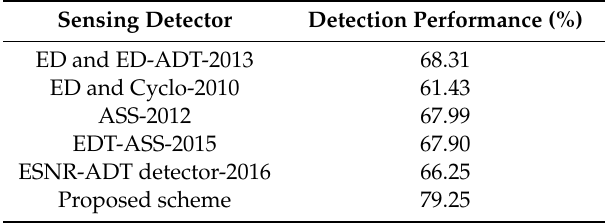
Table 2. Comparison among detectors regarding the probability of detection.